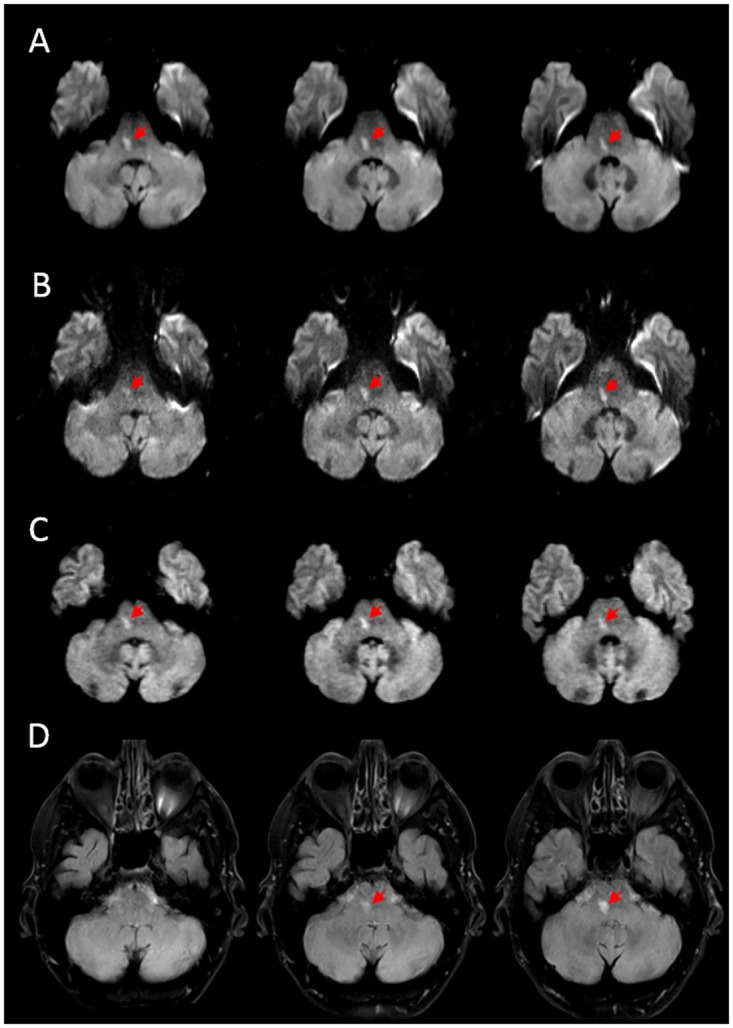
Representative example of agreement between DWI sequences for a patient studied 8 hours after onset of stroke symptoms.Both low- (A) and high-resolution (B) EPI-DWI show a hyperintensity in the right pons spanning three slices. C) STEAM-DWI also shows a hyperintensity in the right pons. D) FLAIR performed five days after baseline scans confirmed the presence of an infarct in the same location. Ischemic lesions are indicated by red arrows.